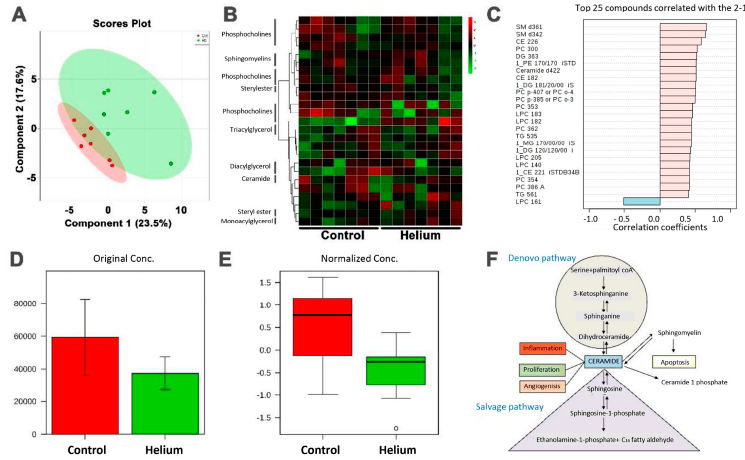
Figure 7. Complex lipid metabolites in serum. ( A ) Partial least squares discriminant analysis (PLS-DA) between He and control groups. ( B ) Heat map based on the normalized data and p values. ( C ) List of metabolites positively and negatively correlated with the He and control groups. ( D,E ) Removing the outliers determined by the Metaboanalyst outlier algorithm show the ceramide group to be differentially regulated in the He versus the control group. ( F ) Sphingolipid metabolic pathway associated with ceramide identified using pathway annotation.